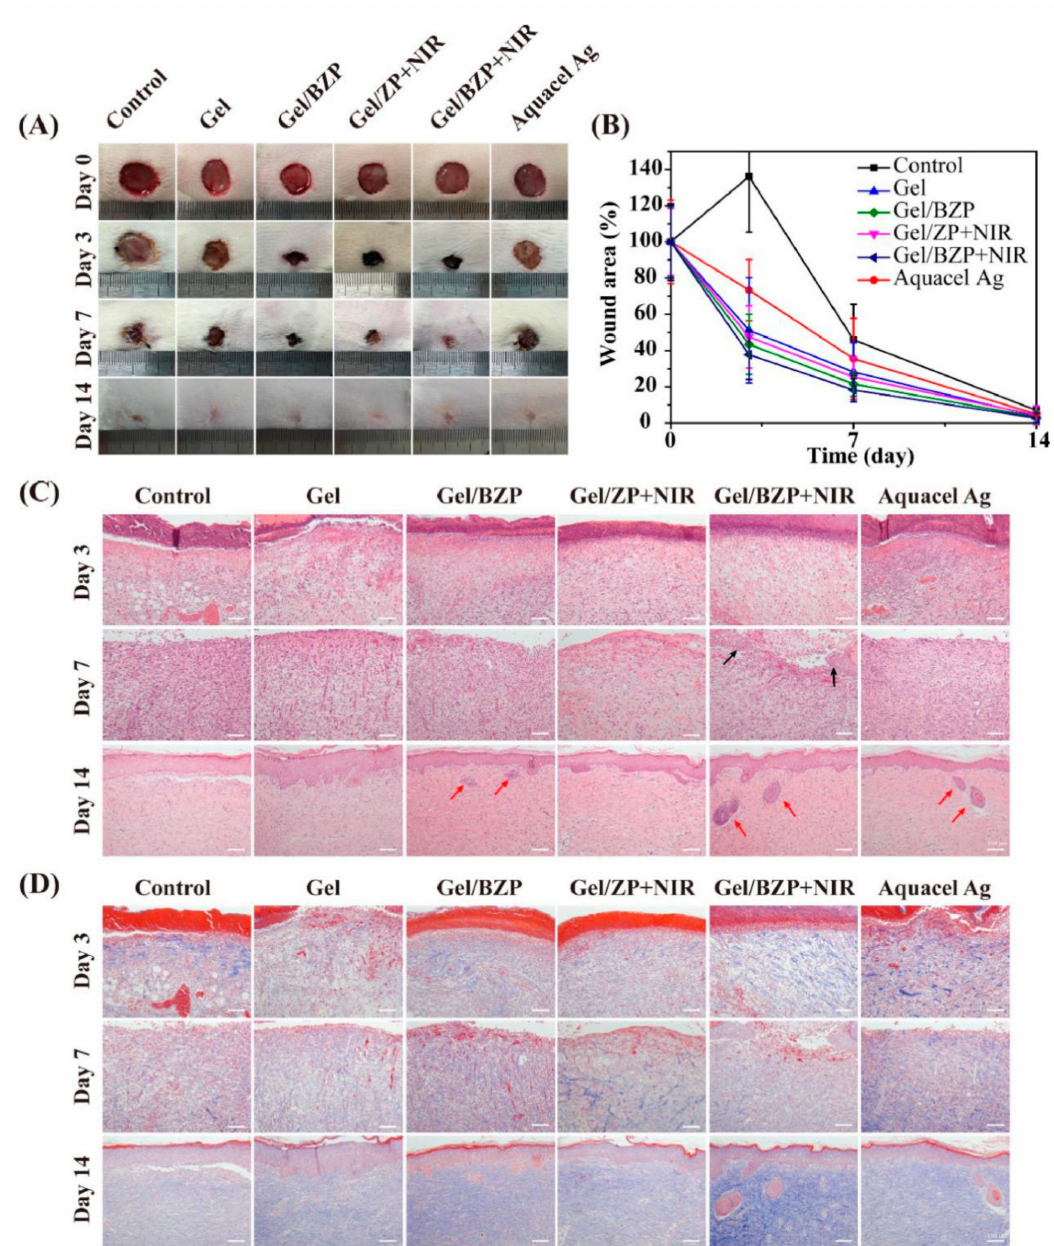
Figure 6. In vivo animal experiment assessment of hydrogels for wound healing. ( A ) Images of wounds treated with different hydrogels on 0, 3, 7, and 14 d. ( B ) Wound area values at different healing times. ( C ) H&E staining and ( D ) Masson’s trichrome staining of the wound section at 3, 7, and 14 d; scale bar = 100 µ m. (ZP: ZIF8/PDA, BZP: BNN6/ZIF8/PDA) [121]. Copyright 2020,